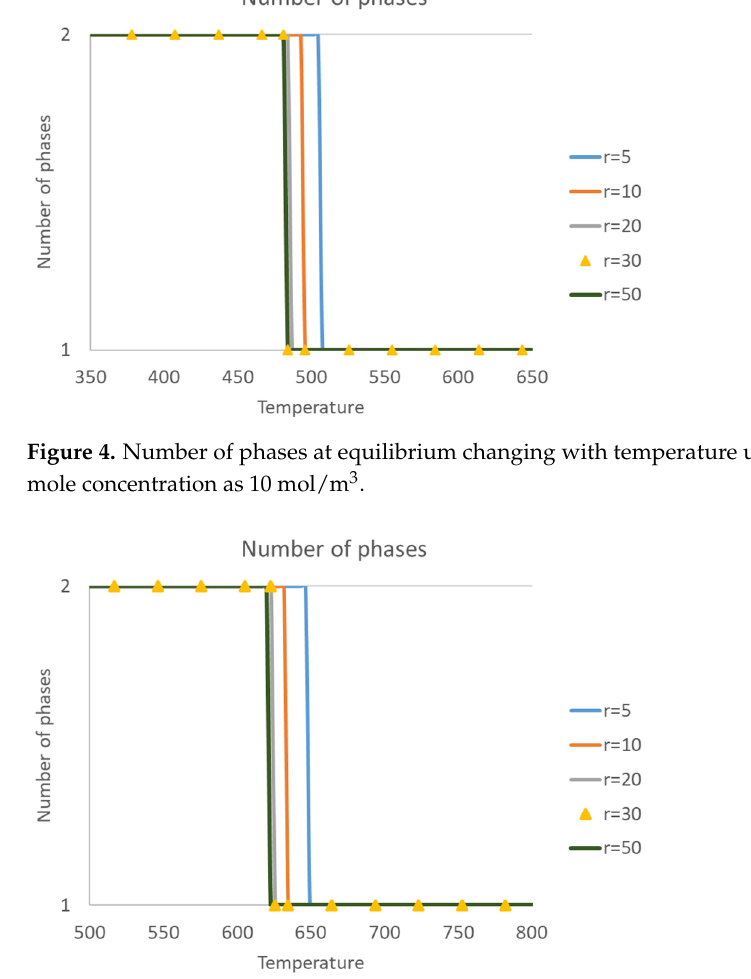
Figure 5. Number of phases at equilibrium changing with temperature under the constant overall mole concentration as 429.65 mol/m 3.